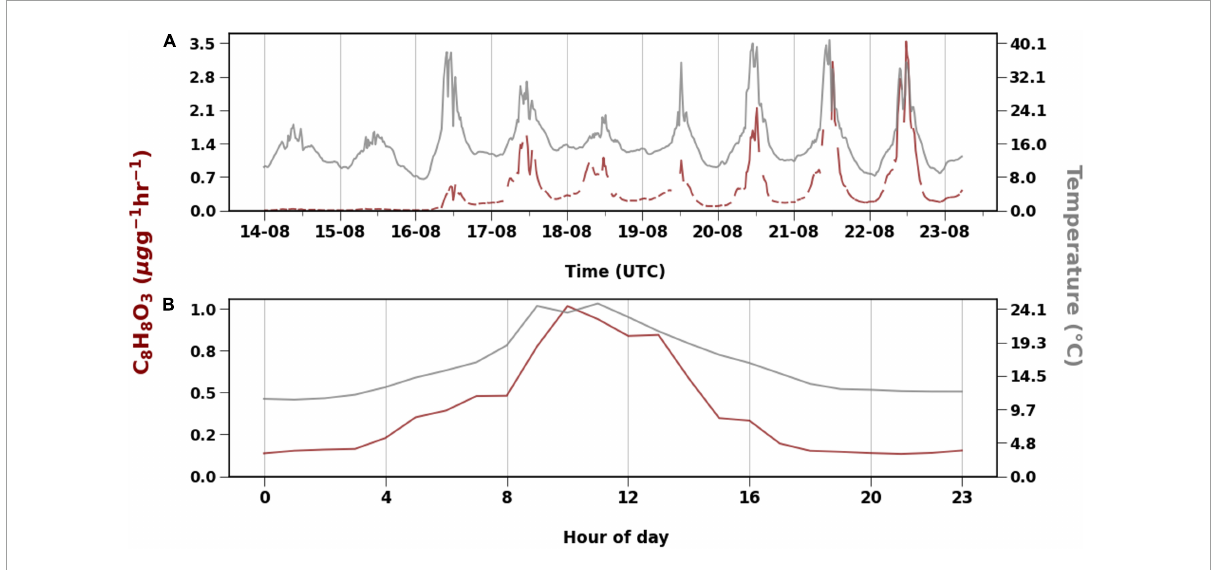
FIGURE6 Emission of C 8 H 8 O 3 with temperature ( ◦ C) for the whole measurement period (A) and diurnal variation (B)